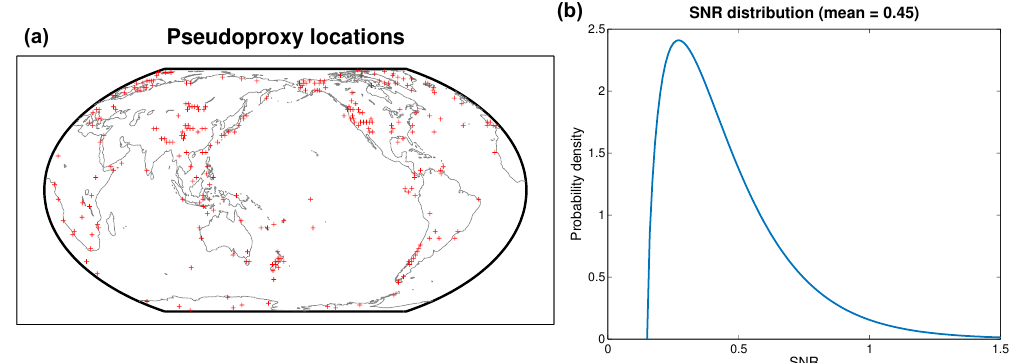
Figure 5. (a) Pseudoproxy locations used in this study ( n = 274), drawn from the predominantly high-resolution (annual) proxy collection of PAGES 2k Consortium (2013) and all the comparatively low-resolution (decadal to centennial) proxy locations in Shakun et al. (2012) and Marcott et al. (2013). (b) The signal-to-noise ratio (SNR) distribution for the pseudoproxies, based on a real-world estimate of Wang et al. (2014). For a given Monte Carlo experiment, the SNR for each pseudoproxy was randomly drawn from this